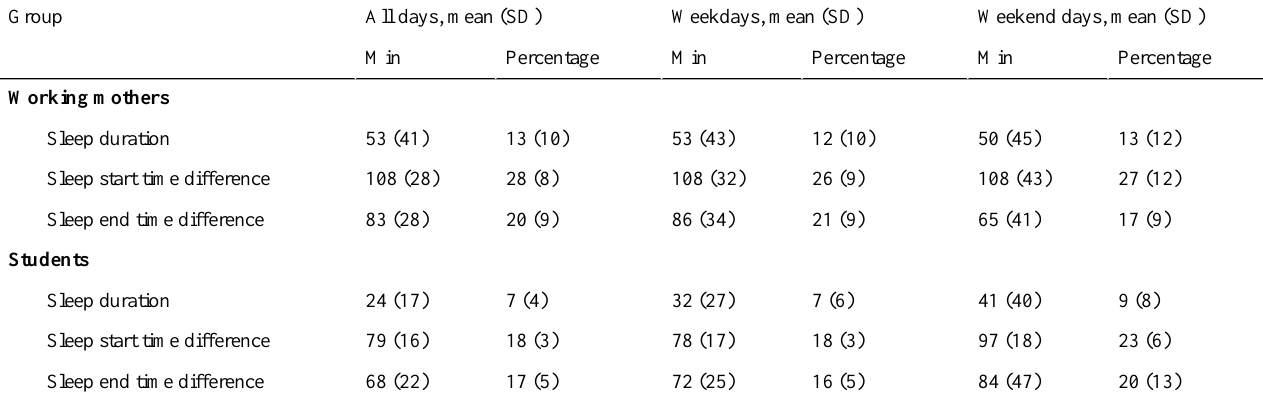
Table 3. Sleep statistics' differences between the BASIS smartwatch and the iSenseSleep